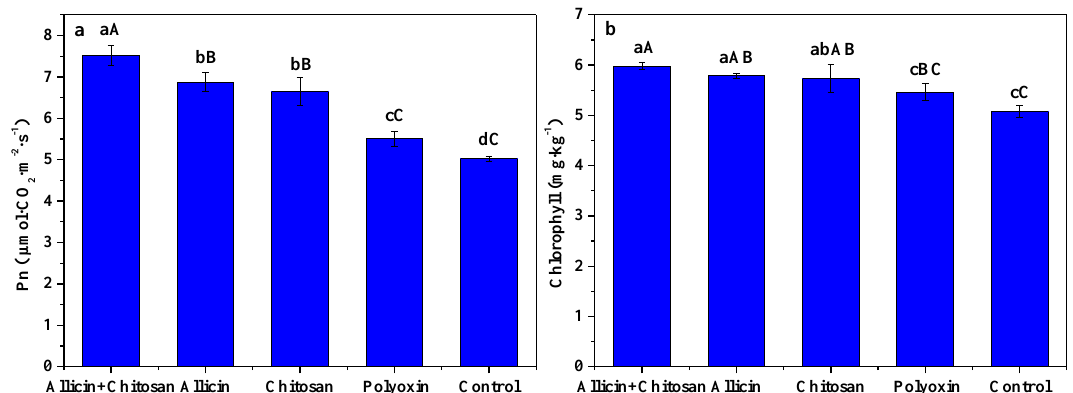
Antibiotics 2021 , 10 , x FOR PEER REVIEW Figure 2. The effects of allicin and chitosan on the photosynthetic rate ( a ) and chlorophyll ( b ) of leaves in R. roxburghii . Values and error bars indicate the mean and SD of three replicates, respectively. Different small letters indicate significant differences at 5% level ( p < 0.05), and different capital letters indicate significant differences at 1% level ( p < 0.01).